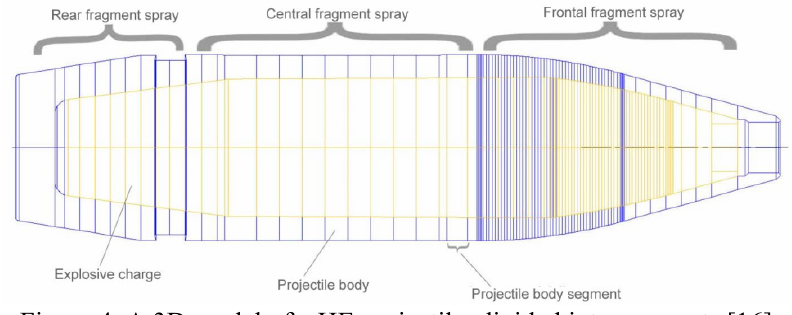
Figure 4. A 3D model of a HE projectile, divided into segments [16]